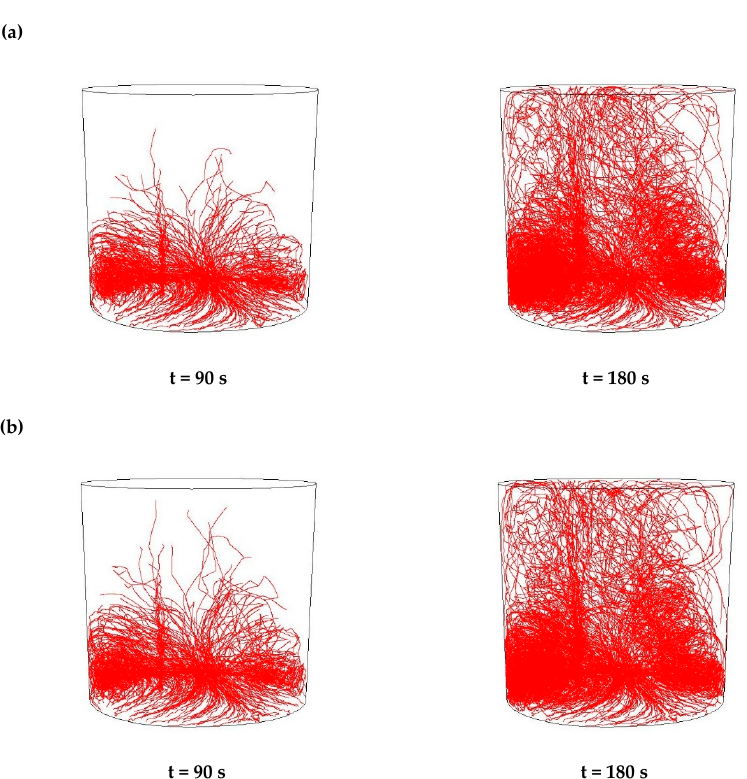
Figure 8. Trajectories of non-metallic MnS inclusions for the case of argon flow of 25 L/min for the particle diameters of ( a ) 18 µm ( b ) 27 µm in the 18CrNiMo7-6 steel.